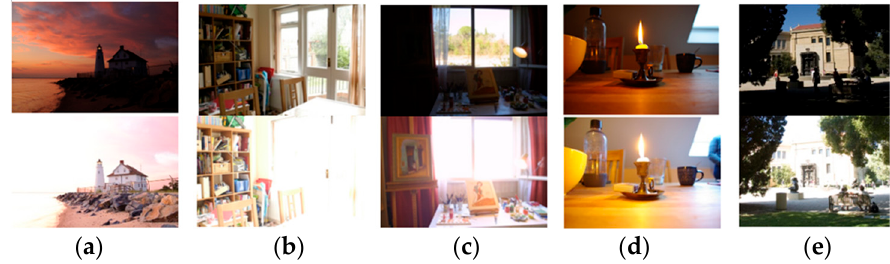
Figure 4. Among them, three groups (Figure 4a–c) were multi-exposure image sequences of static scenes, and the other two groups (Figure 4d,e) were multi-exposure image sequences of dynamic scenes. Figures 5–9 show subjective evaluations of our method.